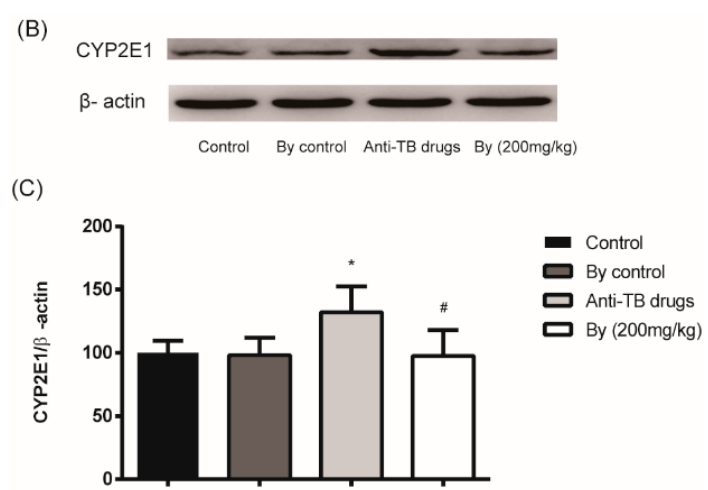
Figure 7. Effect of bicyclol (200 mg/kg) on the activity (A) and protein expression (B and C) of CYP2E1 in anti-TB drug intoxicated rats. *, p < 0.05, ***, p < 0.001 vs. control group; # , p < 0.05, ### , p < 0.001 vs. anti-TB drug intoxicated group.